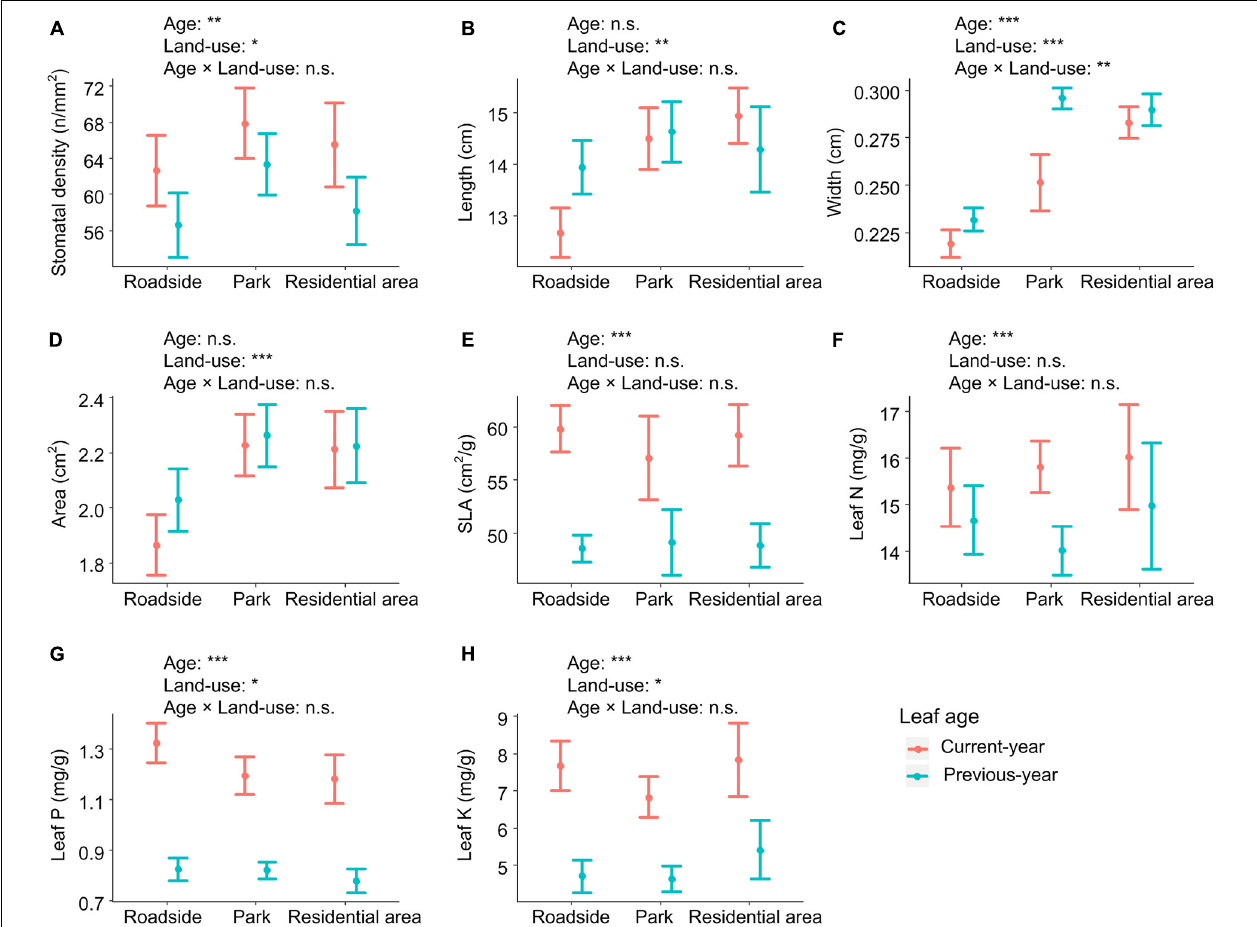
FIGURE 2 | Leaf functional traits (mean values and 95% confidence intervals) of Chinese pine ( Pinus tabuliformis Carr.) differ with leaf age and among land-use types. (A) Stomatal density, (B) Leaf length, (C) Leaf width, (D) Leaf area, (E) Specific leaf area, (F) Leaf N concentration, (G) Leaf P concentration, (H) Leaf K concentration. Significance level: *** p < 0.001; ** p < 0.01; * p < 0.05; n.s., not